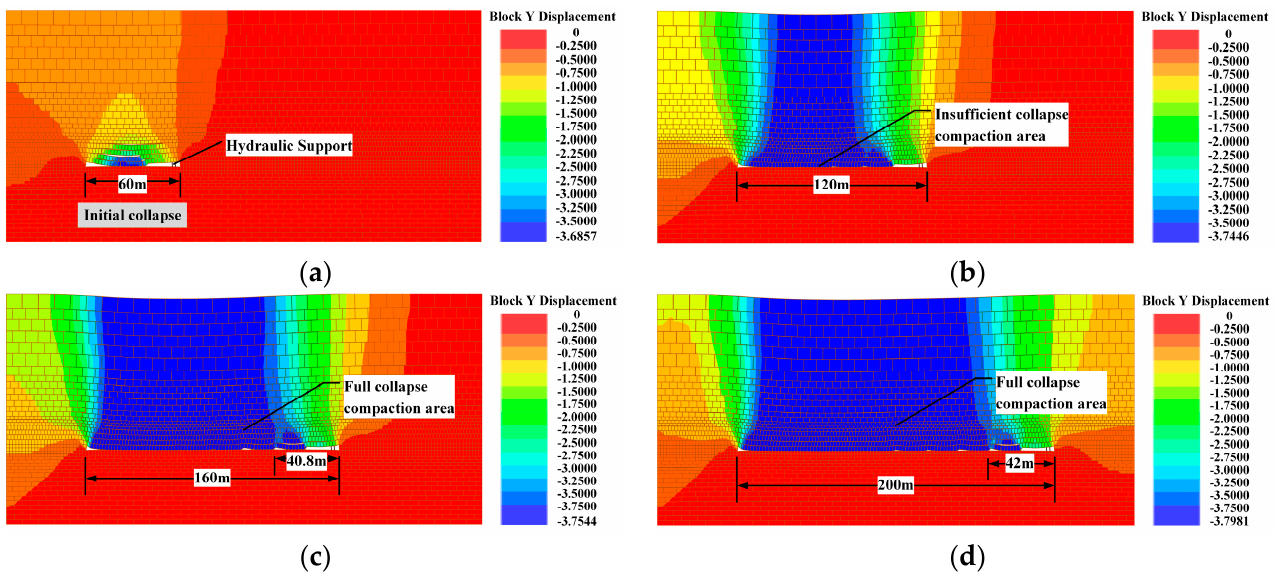
Figure 11. Displacement cloud image after cutting the roof: ( a ) is the displacement state when the working face is first broken after cutting the roof; ( b ) is the displacement state when the working face is excavated for 120 m after cutting the roof; ( c ) is the displacement state when the working face is excavated for 160 m after cutting the roof; and ( d ) is the displacement state when the working face is excavated for 200 m after cutting the roof.